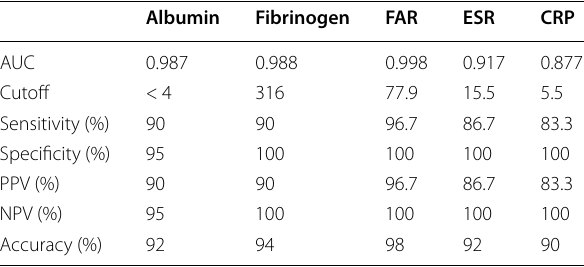
AUC Area under the ROC curve, PPV Positive predictive value, NPV Negative predictive